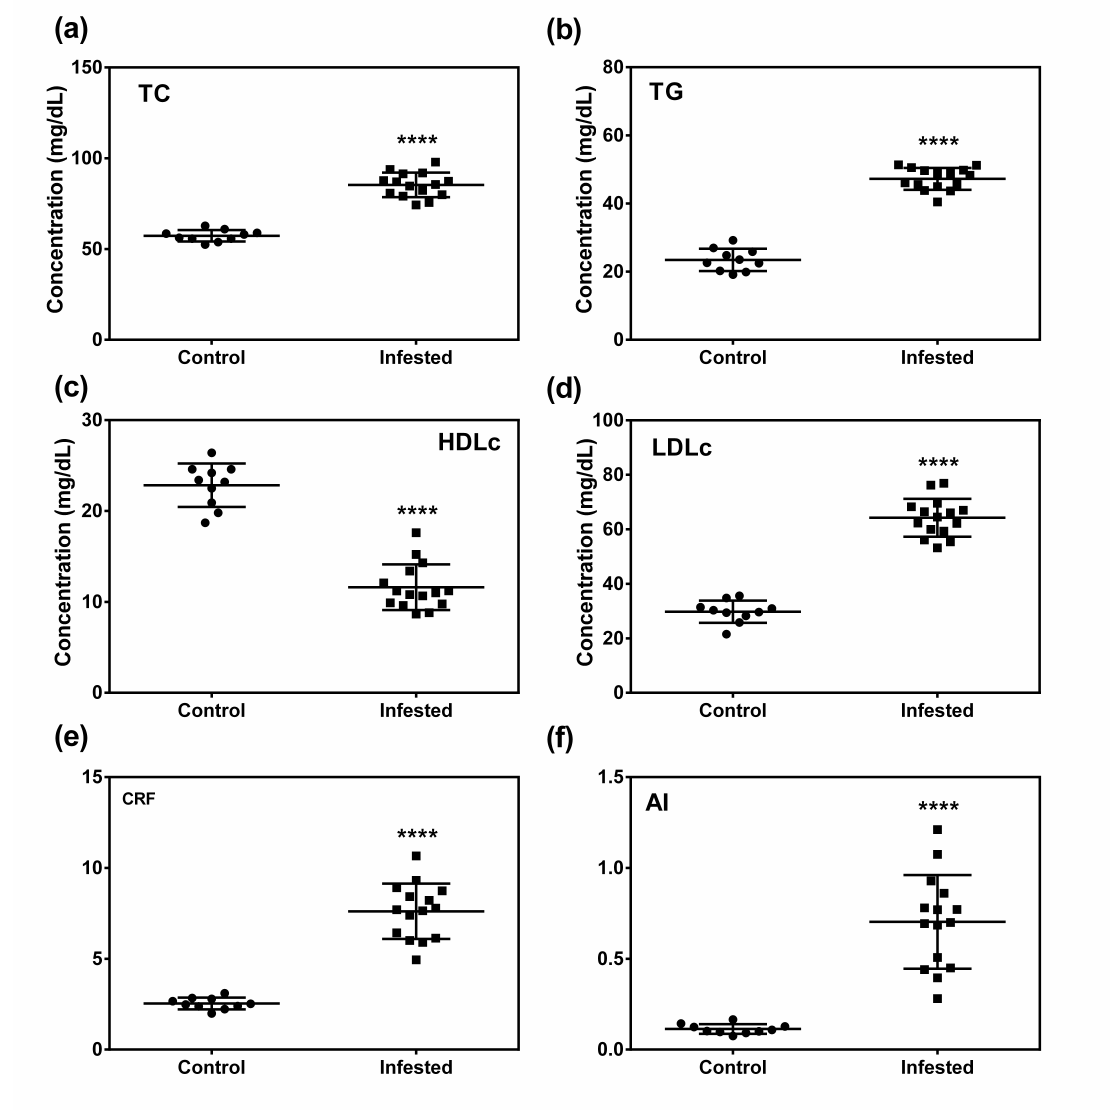
Figure 4. E ff ect of crusted scabies on serum lipid profile in a porcine model. ( a ) Total cholesterol (TC) concentration, ( b ) triglycerides (TG) concentration, ( c ) high-density lipoprotein cholesterol (HDLc) concentration, ( d ) low-density lipoprotein cholesterol (LDLc) concentration, ( e ) cardiac risk factor (CRF), ( f ) atherogenic index (AI). Data in scatter plot are shown as mean ± SD. t -test was performed to find out significant di ff erence between the two groups. **** denotes p ≤